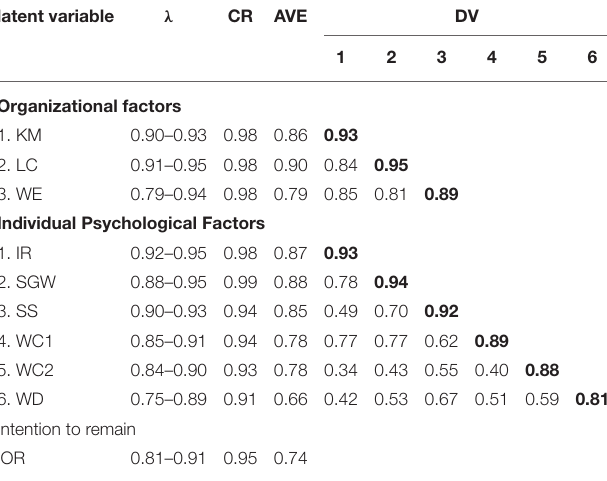
TABLE 1 | Confirmatory factor analysis